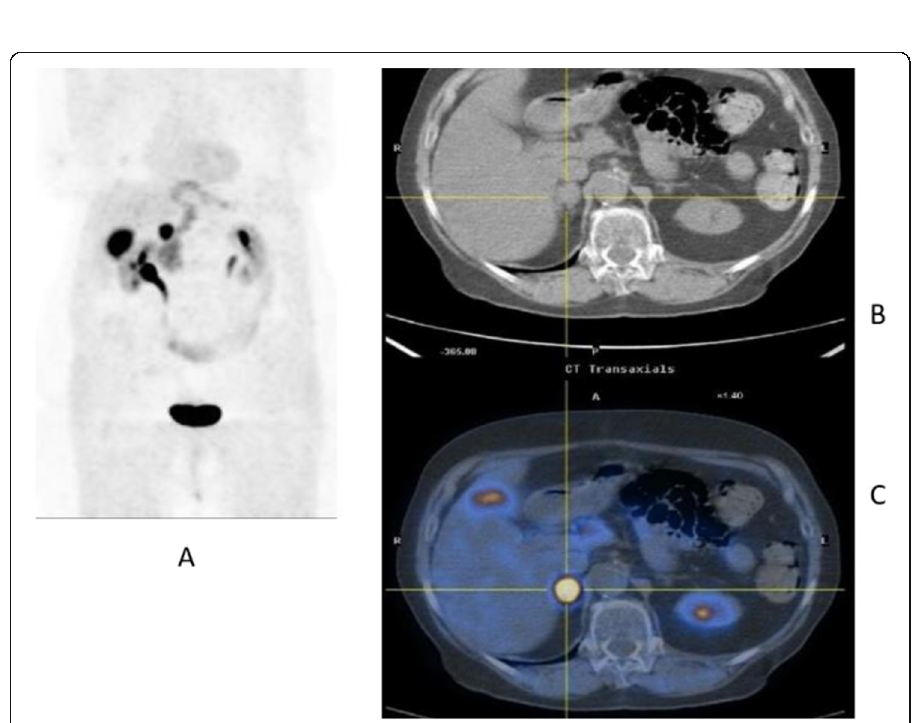
Fig. 41 18 F-FDOPA, pheochromocytoma. Clinical history : 45 y.o. man with resistant hypertension. Clinical suspicion of phaeochromocytoma. PET/CT findings : intense uptake of the tracer in the right adrenal gland in MIP ( a ), which is enlarged on CT ( b ) and fused images ( c ). Surgery confirmed presence of